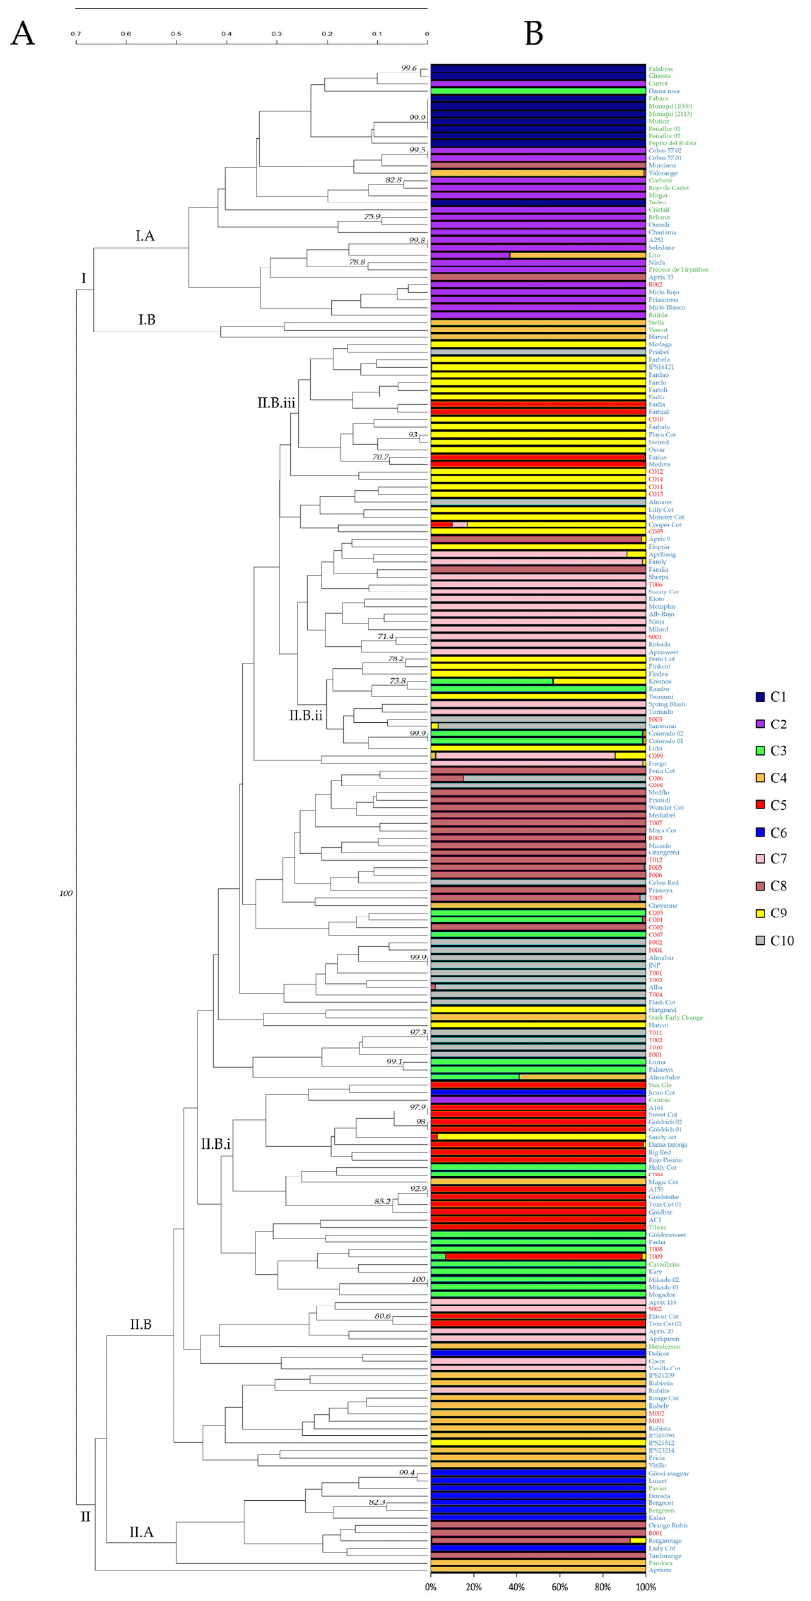
Figure 1. Clustering of the 201 apricot cultivars and one interspecific hybrid (aprium) included in this study. ( A ) The dendrogram was constructed based on UPGMA analysis using the similarity matrix generated by the Nei and Li coefficient. The numbers at specific nodes represent the